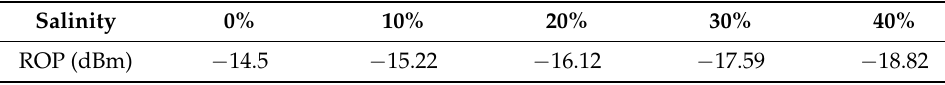
Figure 8. BER performance versus water salinity under different SFO. Subfigures show the 16-QAM constellations when the SFO is ( a ) 1000 ppm; ( b ) 200 ppm; ( c ) 0 ppm. Table 3. The receiving optical power at different salinities.